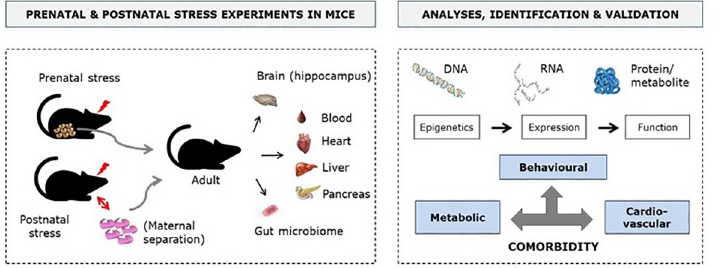
Fig 4. Overview of the experiments and analyses in rodents to identify molecular pathways linking ELS to PCM multi-morbidity.